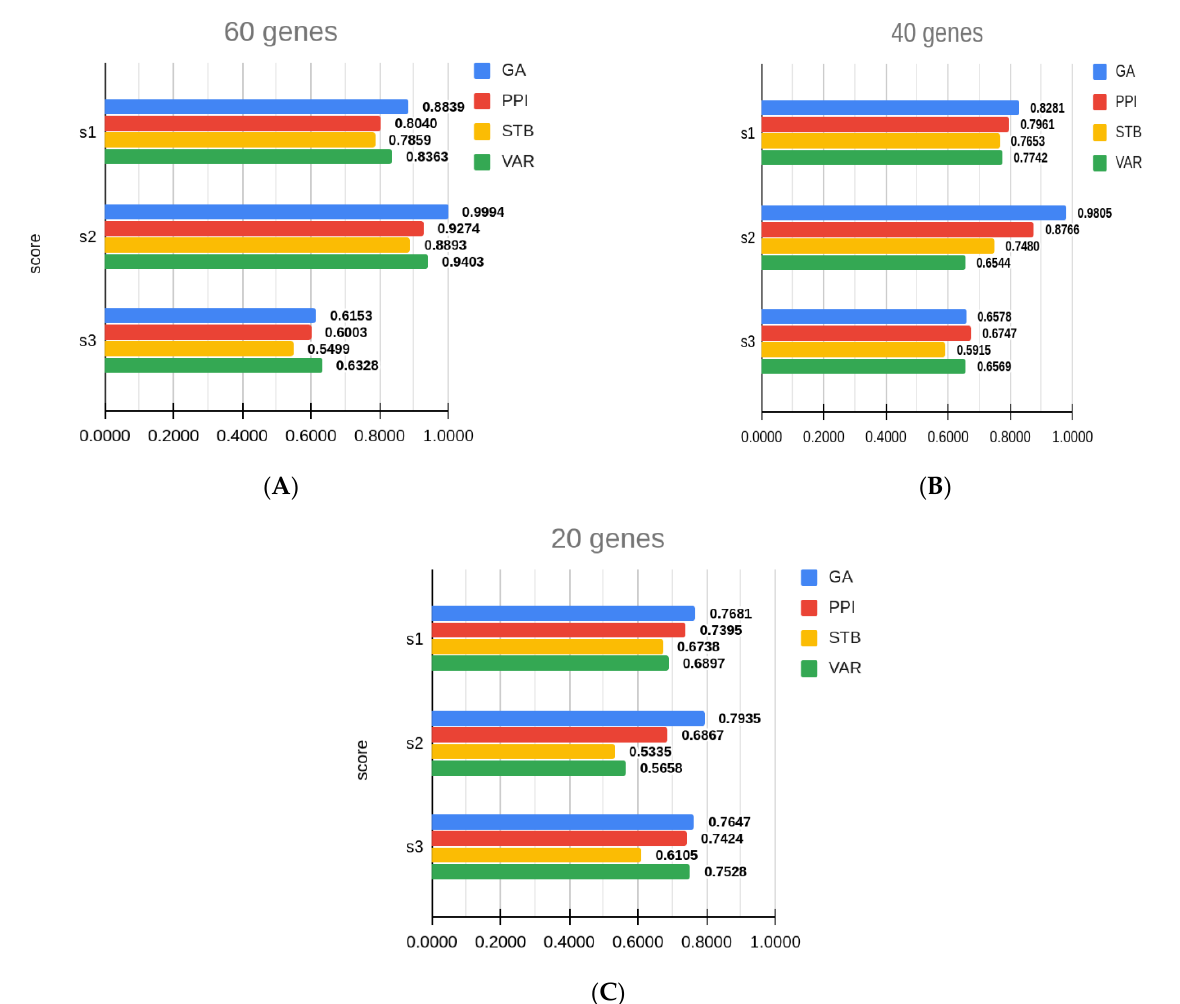
Figure 4. Barplot showing comparison of three DREAM sub-challenge score (s1, s2 and s3 are shown in ( A ), ( B ) and ( C ) respectively) of gene sets generated by different methods (GA = genetic algorithm, PPI = protein–protein interaction network, STB = least variable genes (stable), VAR = most variable genes) after bootstrapping 1000 times. Score definitions are as provided by DREAM sub-challenge.